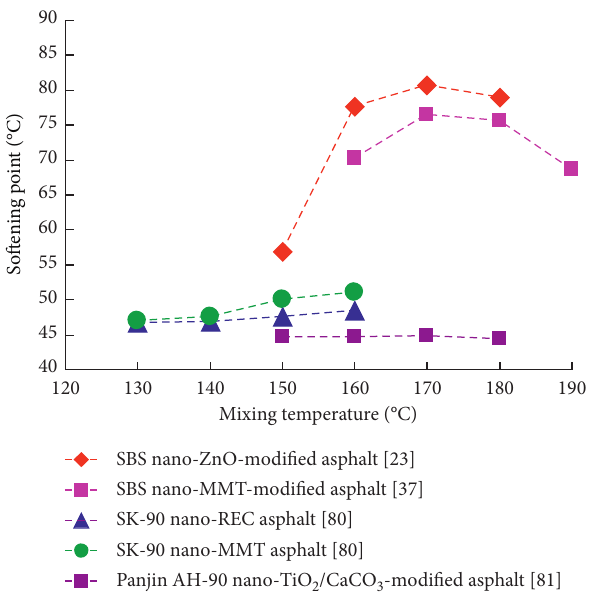
Figure 19: Mixing temperature effect on softening point.